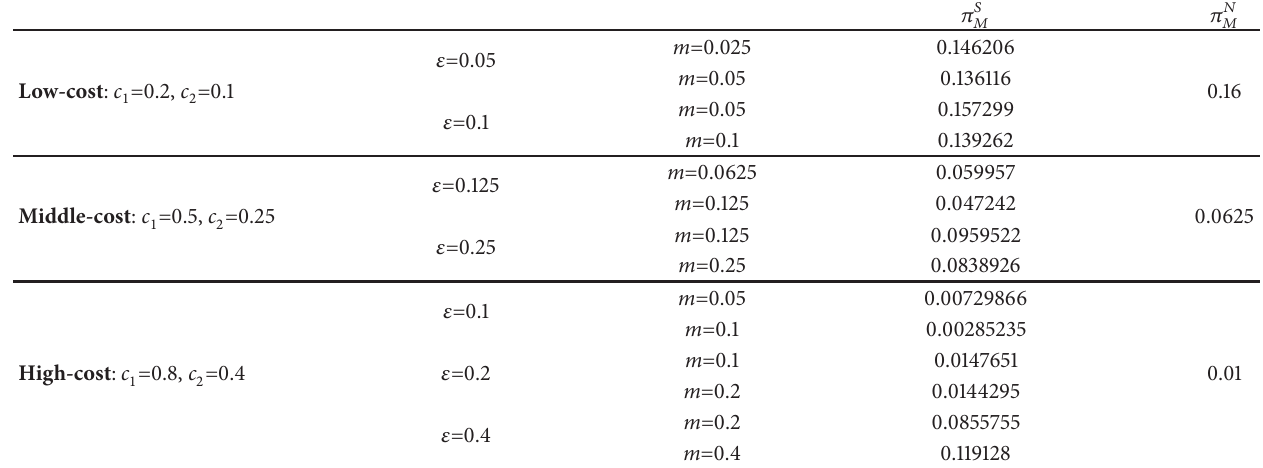
Table 3: Examples with different costs of